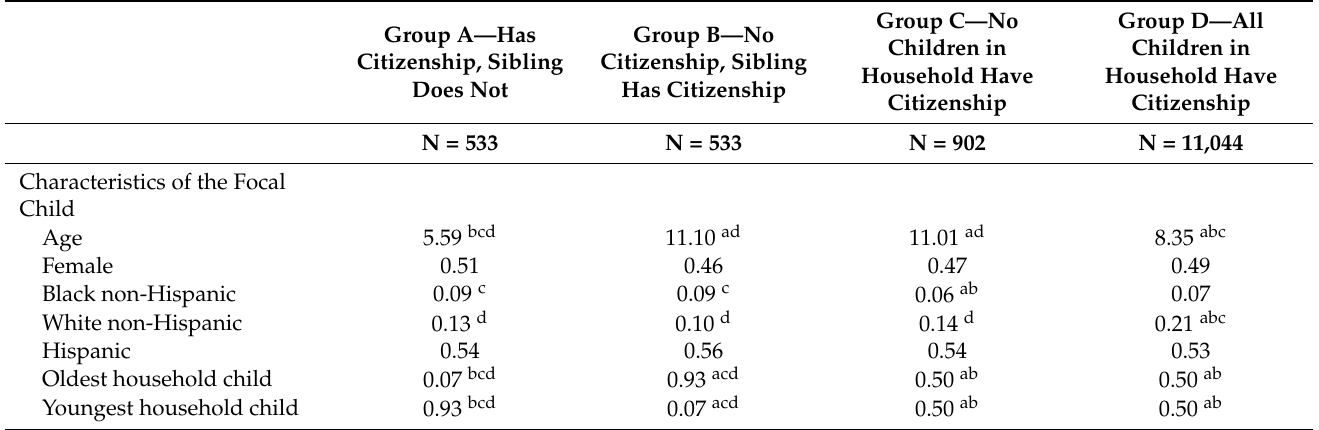
Table 1. Individual and Household Characteristics of Children of Parent Respondents in Immigrant